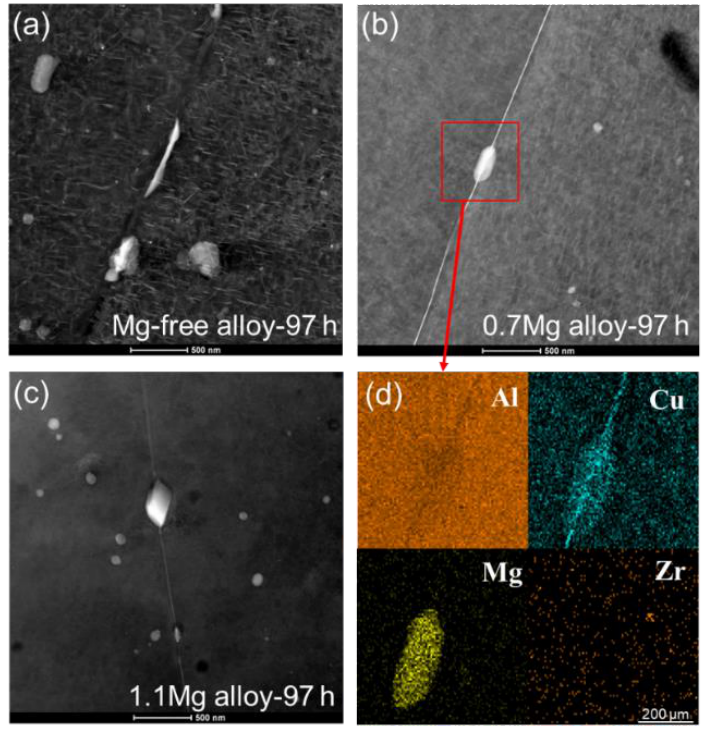
Figure 9. HAADF STEM images after being aged at 150 °C for 97 h for Al – Cu – Li alloys with different Mg content (Mg-free alloy ( a ), 0.7Mg alloy ( b ), 1.1Mg alloy ( c )), and corresponding EDS mapping images of Figure 8b ( d ).